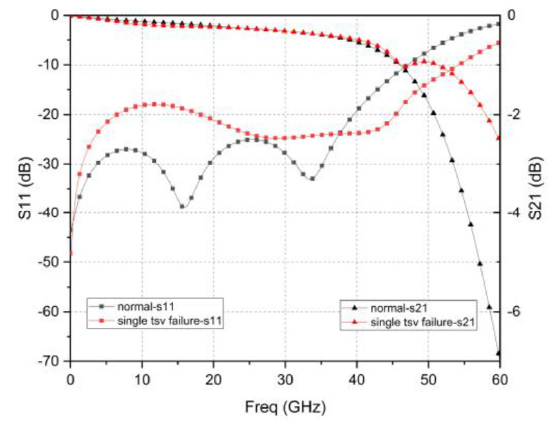
Figure 6. Dual redundant TSV failure simulation results.